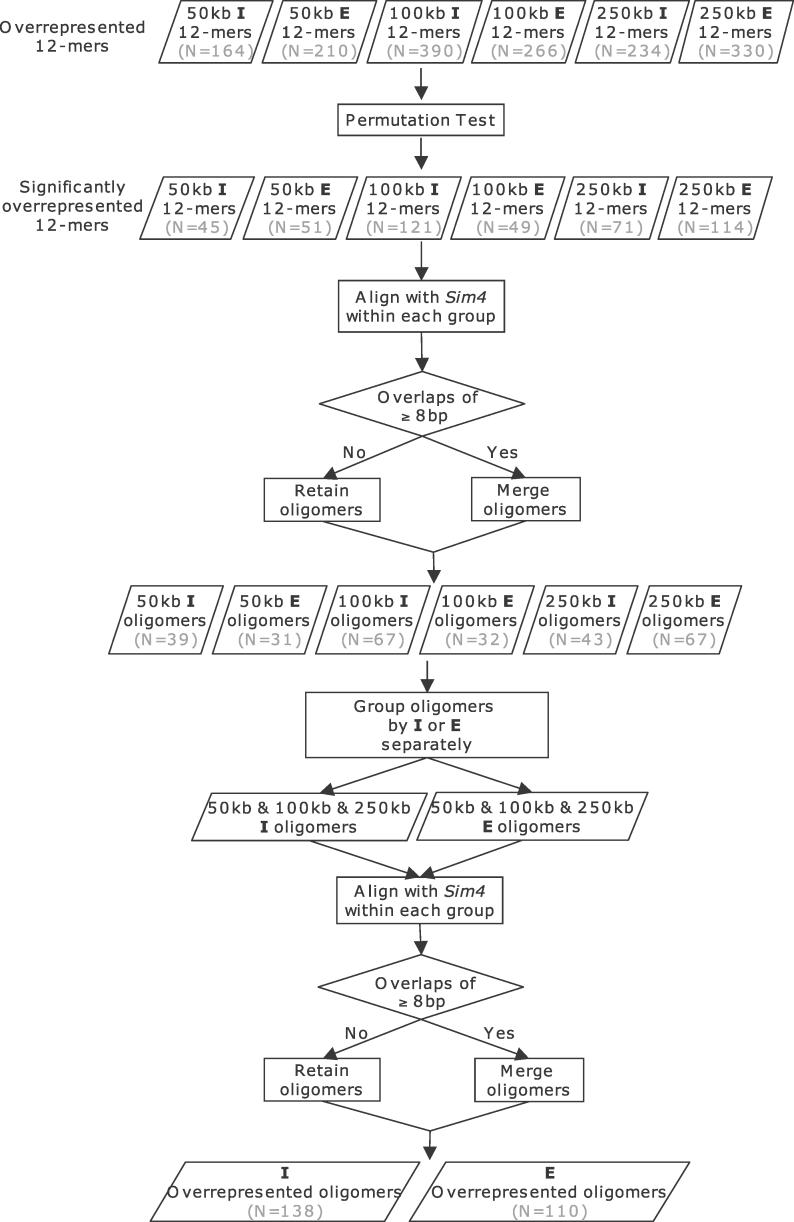
Procedure Used to Obtain Overrepresented Oligomers Starting from the Overrepresented 12-MersThe overrepresented 12-mers were defined with the initial criteria: at least ten occurrences and at least 5-fold enrichment. See Results and Methods for a detailed description.